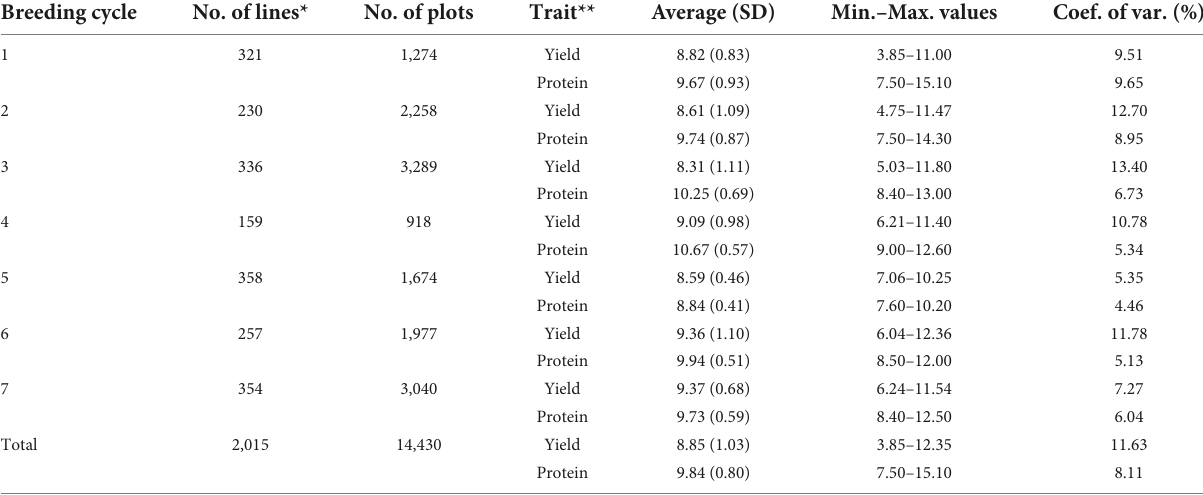
TABLE 3 Descriptive statistics for the grain yield and protein content of F6 wheat breeding lines. Breeding